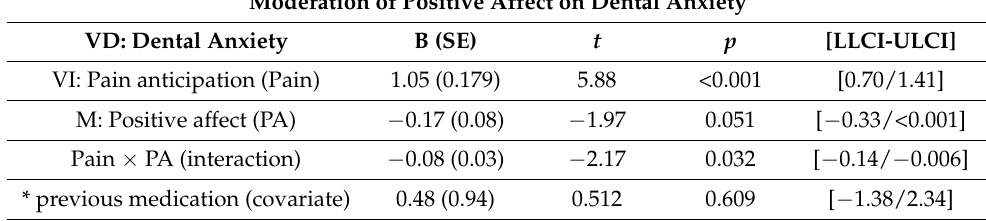
Table 2. Moderate mediation